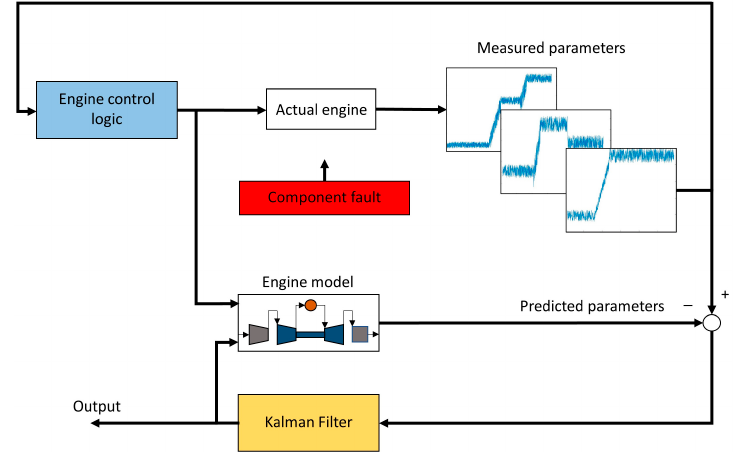
Figure 12 . GT health monitoring using KFs. Figure 12. GT health monitoring using